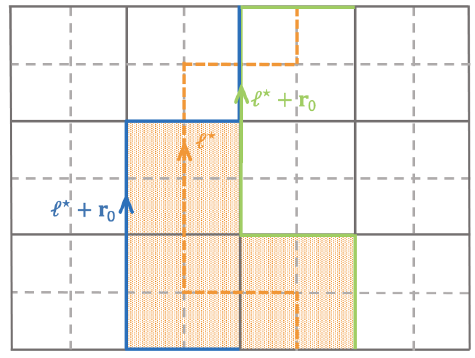
Figure 3. Illustration for plaquettes (shaded) that are ‘sandwiched’ by ‘ ? ± r 0 in